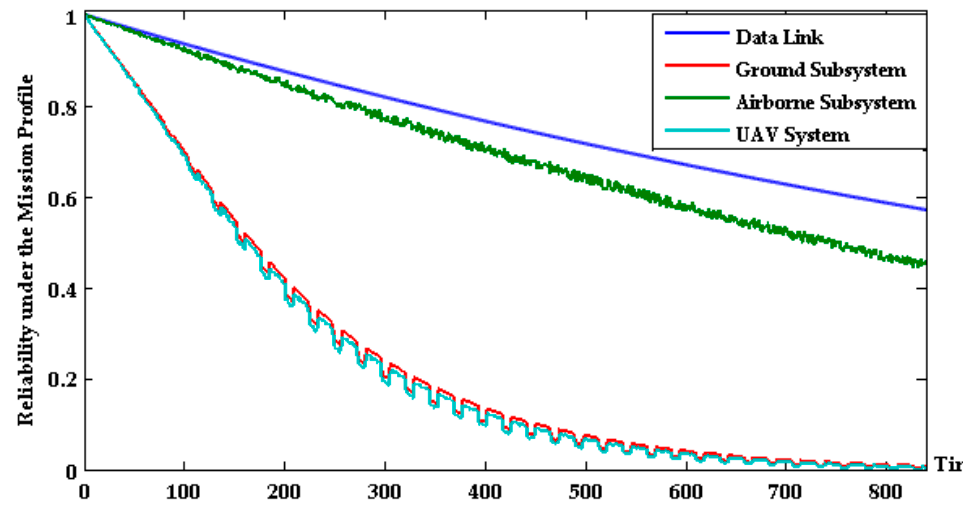
Figure 15. Probability prediction curve of unmanned system state.